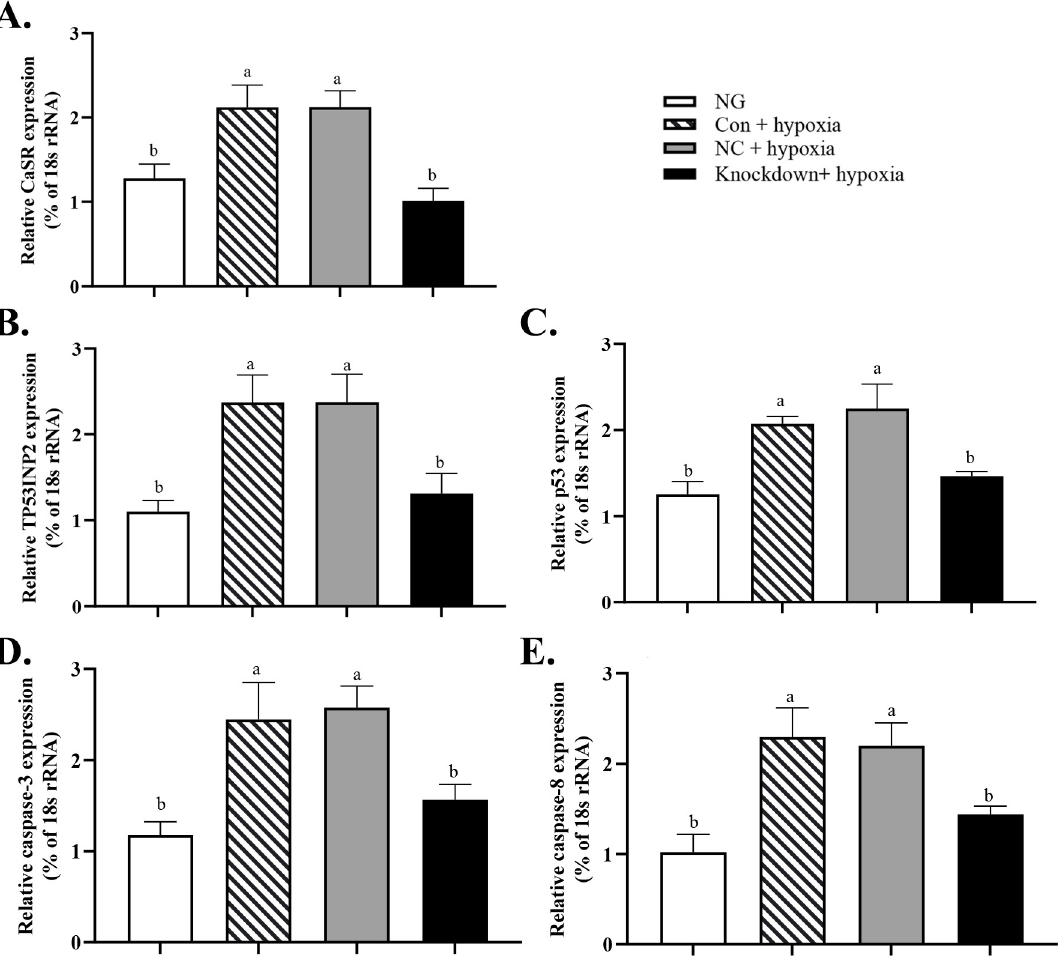
Fig 3. Effect of CaSR knockdown on transcript levels of CaSR , p53 , p53-inducible nuclear protein 2 , caspase-3 , and caspase-8 in GIFT hepatocytes under hypoxia stress. (A) Effect of CaSR knockdown on transcript levels of CaSR in GIFT hepatocytes under hypoxia stress. Hepatocytes were transfected with CaSR knockdown, NC, or Con vector using Lipofectamine 2000 and subjected to 24 h of hypoxia stress in an incubator (knockdown+ hypoxia; NC+ hypoxia, and Con+ hypoxia, respectively). Normal group (NG): hepatocytes under normoxic conditions (no transfection, no hypoxia). (B, C, D, and E) Effect of CaSR knockdown on transcript levels of p53 , p53-inducible nuclear protein 2 , caspase-3 and caspase-8 in GIFT hepatocytes under hypoxia stress. Based on relative levels of respective mRNAs in NG, relative mRNA levels in each group were determined by 2 - ΔΔ CT method. Different lowercase letters indicate significant differences among experimental groups (Duncan’s multiple range test, P < 0.05). https://doi.org/10.1371/journal.pone.0238897.g003 PLOS ONE | https://doi.org/10.1371/journal.pone.0238897 November12,